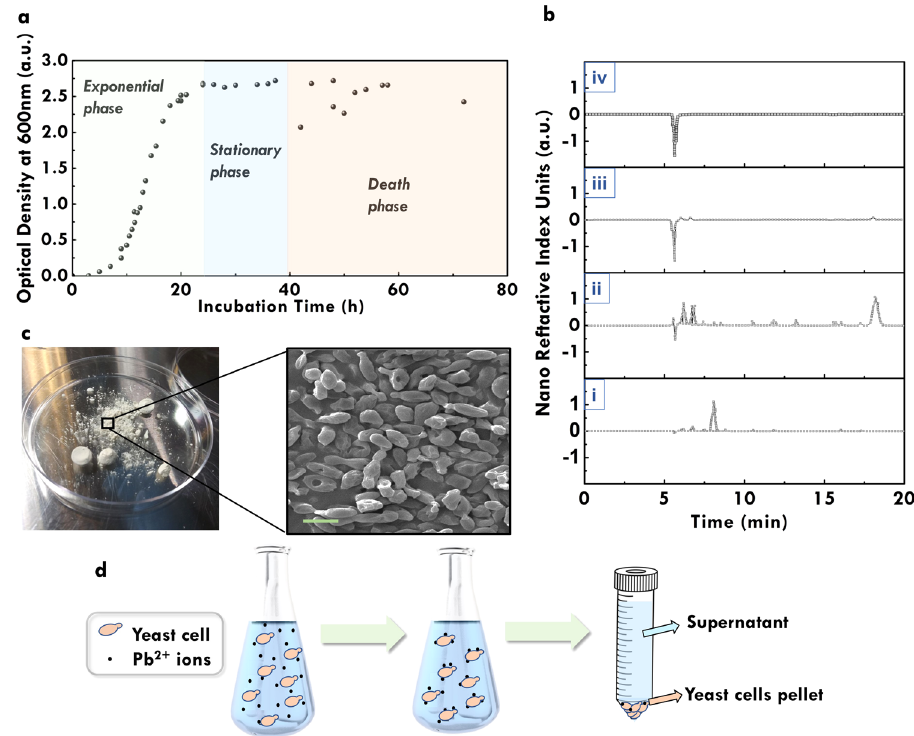
Fig. 1 Overview of experimental procedures. a Measured growth curve of S. cerevisiae yeast cells (absorbance accuracy is approximately 1.75% of reported values). b High-performance liquid chromatography (HPLC) analysis results, performed to identify the number of washes with ultrapure water required to remove medium residues and metabolites from harvested yeast cells before being used in biosorption experiments: i) pure culture medium showed a peak at 8 mins representing glucose; ii) in the supernatant of the harvested liquid culture, glucose was not present but ethanol was produced (peak at 18 mins); iii) in the supernatant after the fi rst wash of yeast cells with ultrapure water there were almost no peaks representing the presence of sugars or organic acids in the solution; iv) in the supernatant after the second wash of yeast cells with ultrapure water there were no peaks at all. Therefore, it was decided to wash the harvested cells twice to ensure absence of organic compounds that might affect further experiments. c Yeast powder after lyophilization and scanning electron microscopy (SEM) imaging of freeze-dried yeast cells (scale bar: 5 μ m). d Main steps of kinetic and equilibrium experiments involving the addition of freeze-dried yeast cells in Pb-containing aqueous solutions, the adsorption of Pb ions, and the separation of biomass and supernatant after the required contact time via centrifugation for further